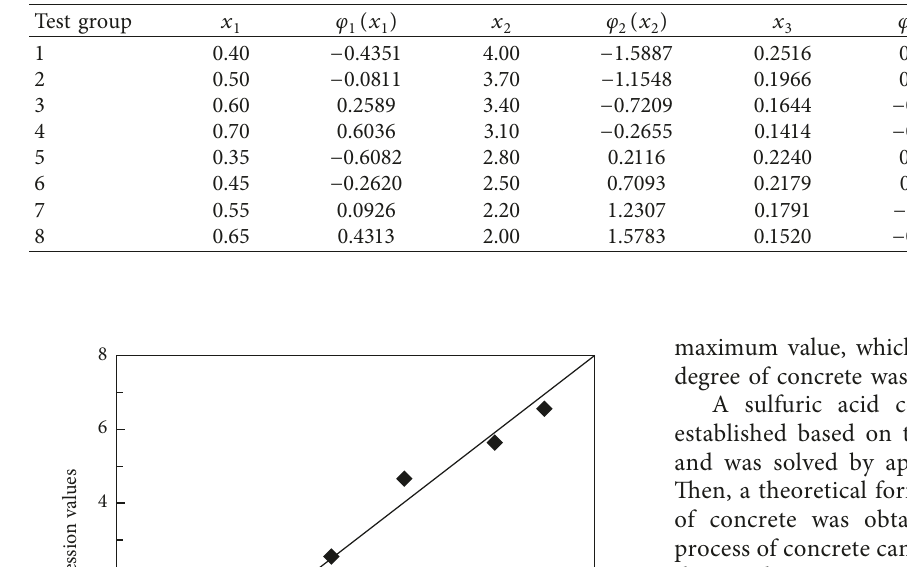
Figure 7: Apparent diffusion coefficient for OH Table 6: Values of each parameter before and after ACE regression.